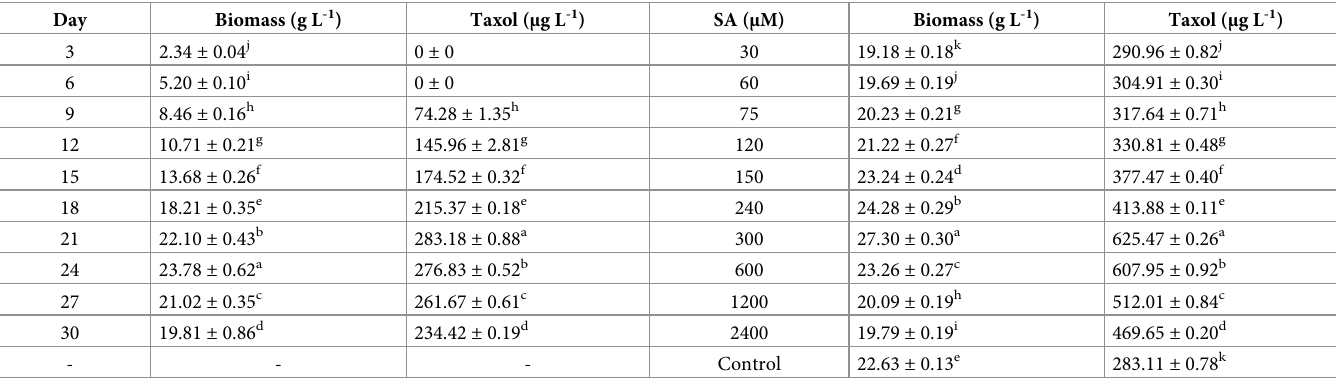
Table 1. Fungal biomass and taxol production by P . microspora on different days and with different concentrations of SA supplementation.